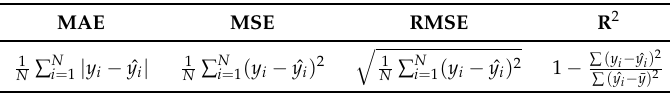
Table 3. Metrics for performance